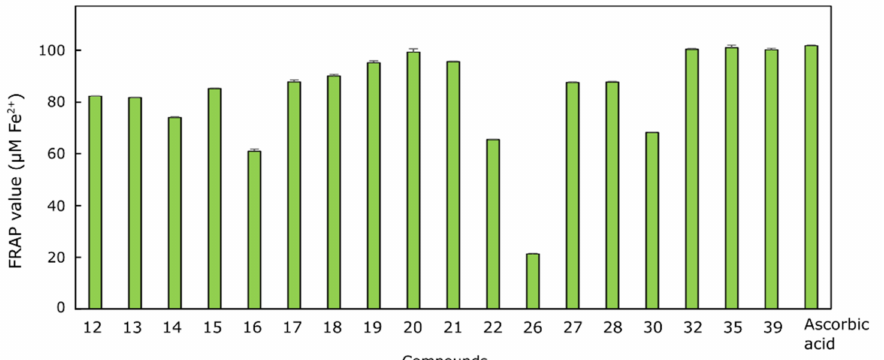
Figure 5. Antioxidant activity levels of compounds 12 – 22 , 26 – 28 , 30 , 32 , 35 and 39 tested by Ferric reducing antioxidant power assay. For each assay, 100 µ L each of the tested compound solution (20 mM) and positive control (20 mM ascorbic acid) were mixed with 3 mL of the FRAP reagent (negative control: 3 mL FRAP reagent and 100 µ L DMSO). The absorbance of the reaction mixture at 593 nm was measured spectrophotometrically after 5